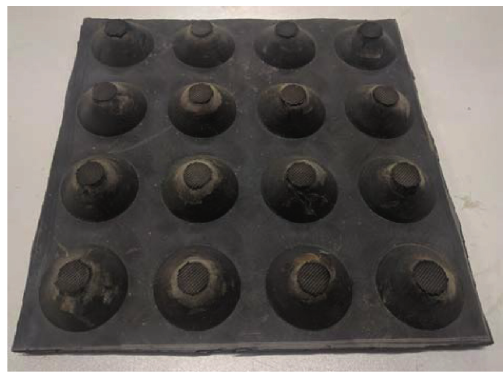
Figure 4: Structure of the rubber isolation layer.